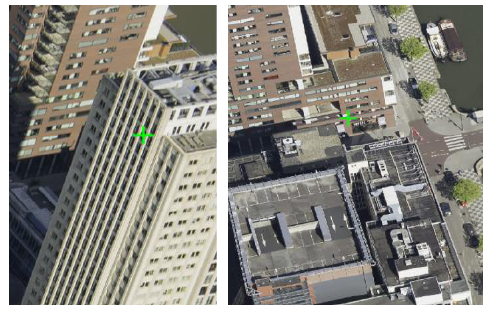
Figure 6. Back-projected patch centre coordinate. Left: False positive of visibility hypothesis. Right: True positive of visibility hypothesis of the same point